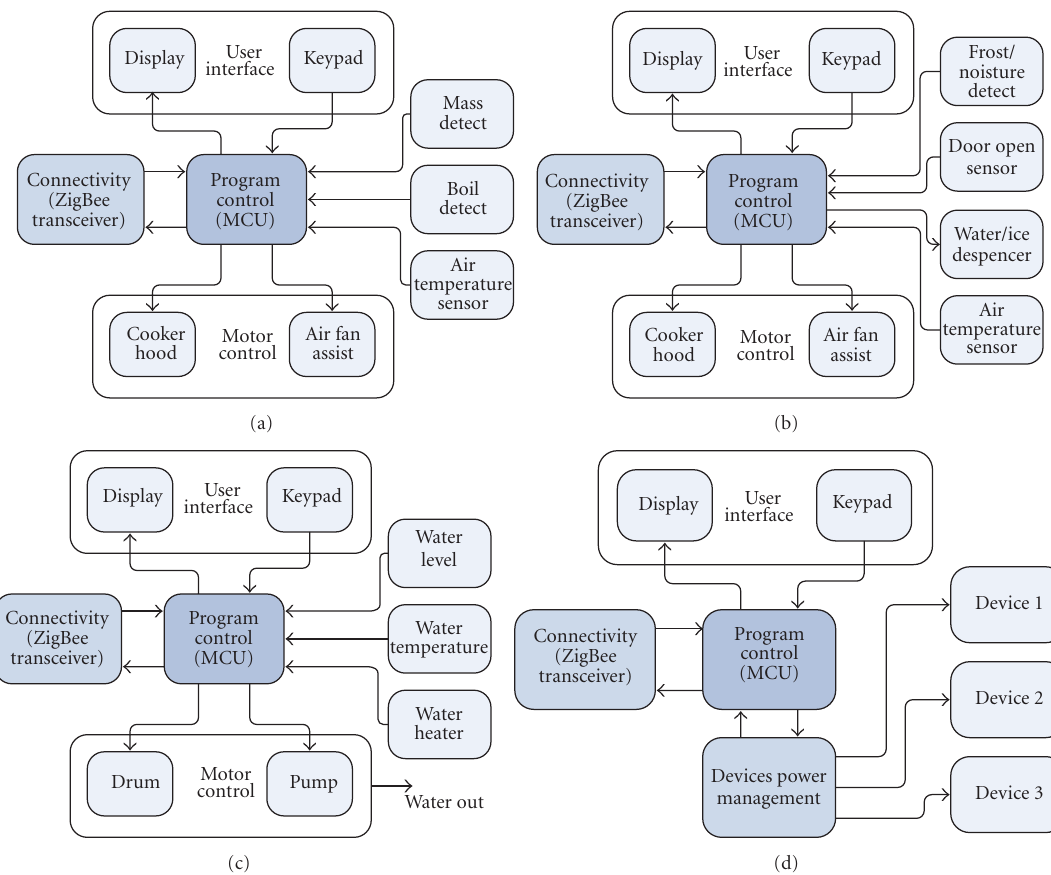
Figure 9: Oven (a), refrigerator (b), washing machine (c), and home plug (d) system diagram.